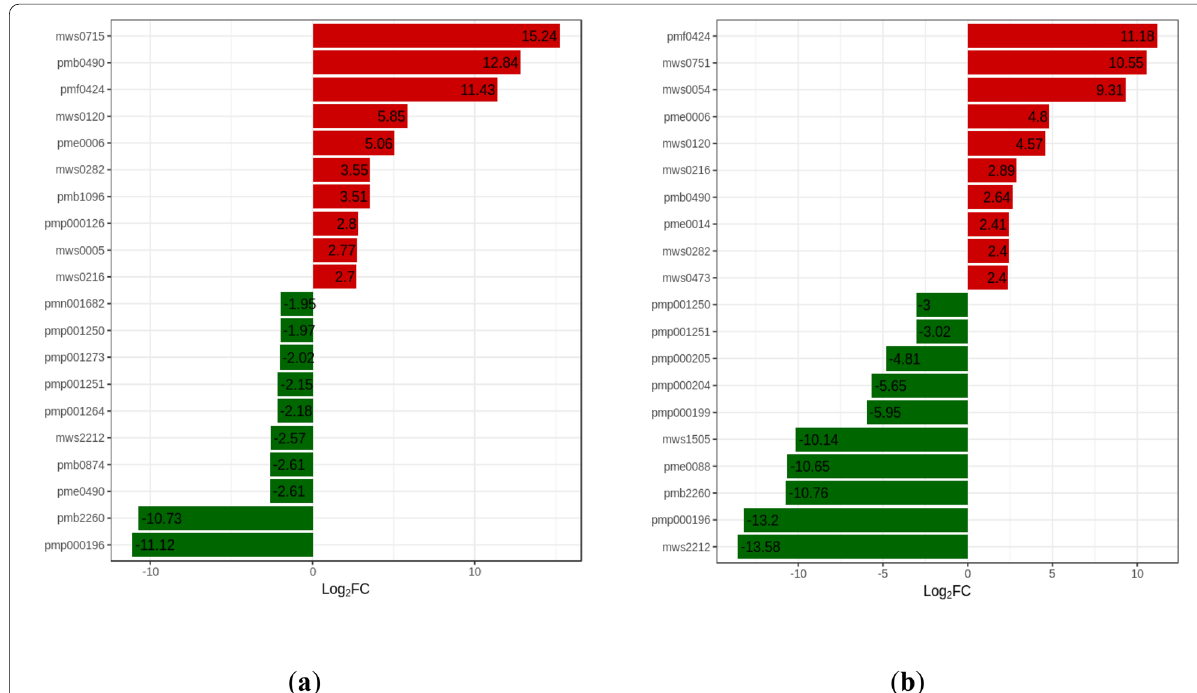
Fig. 7 Column graph of log 2 FC values of the top 20 differential metabolites. a HN44-CK vs. HN44-DS; b HN65-CK vs. HN65-DS. The abscissa is the log2FC of the differential metabolites, and the ordinate is the differential metabolites. Red represents up-regulation, green represents